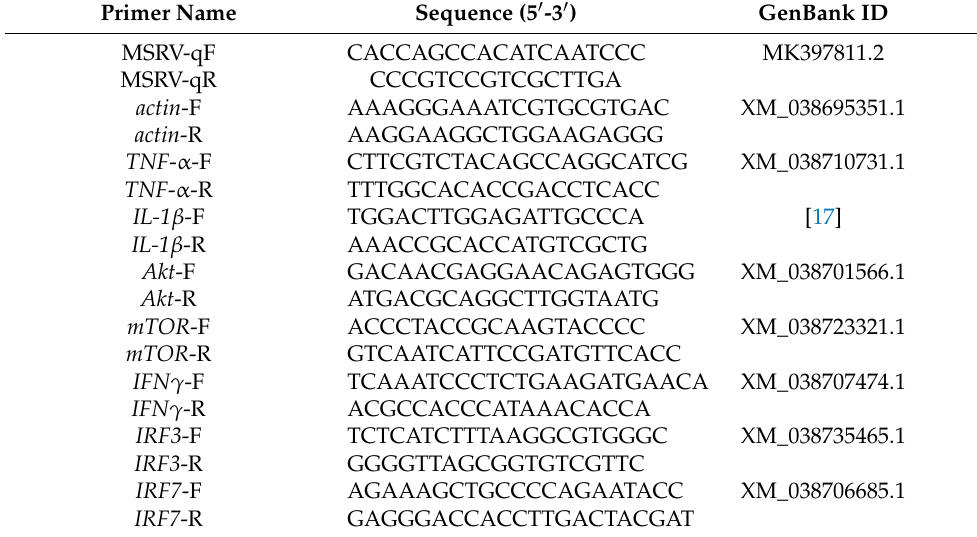
Table 1. Primers used in this